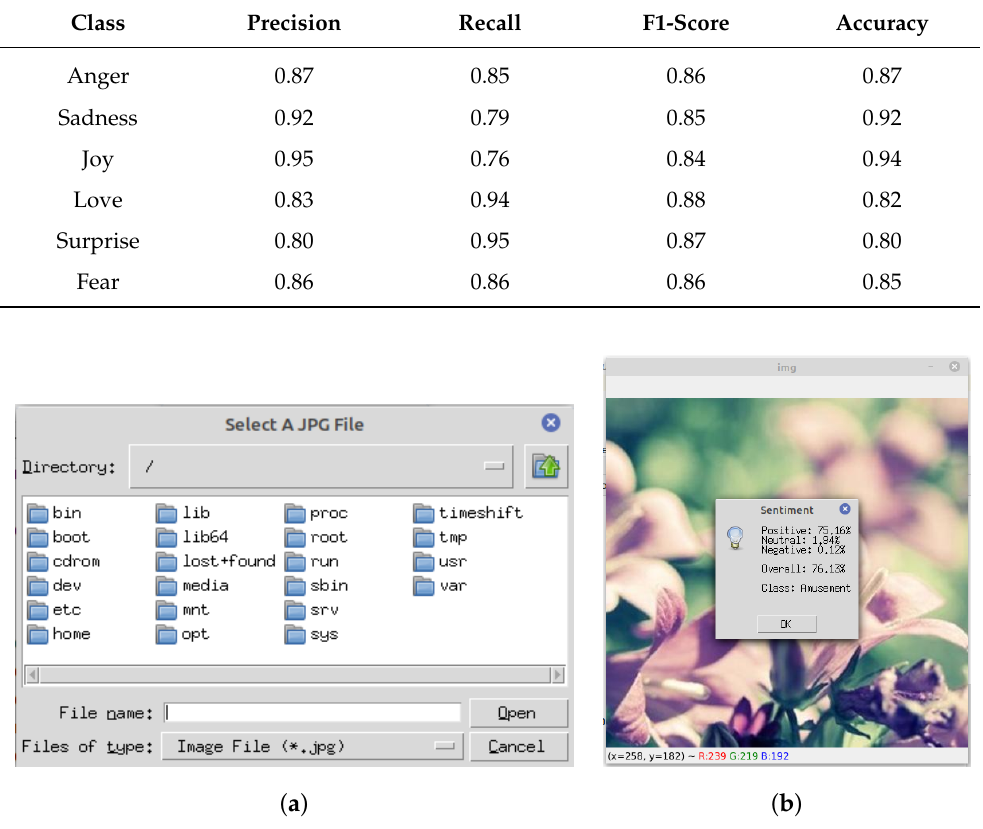
Figure 9. Real-time prediction: ( a ) select an image from directory; ( b ) sentiment analysis of the selected